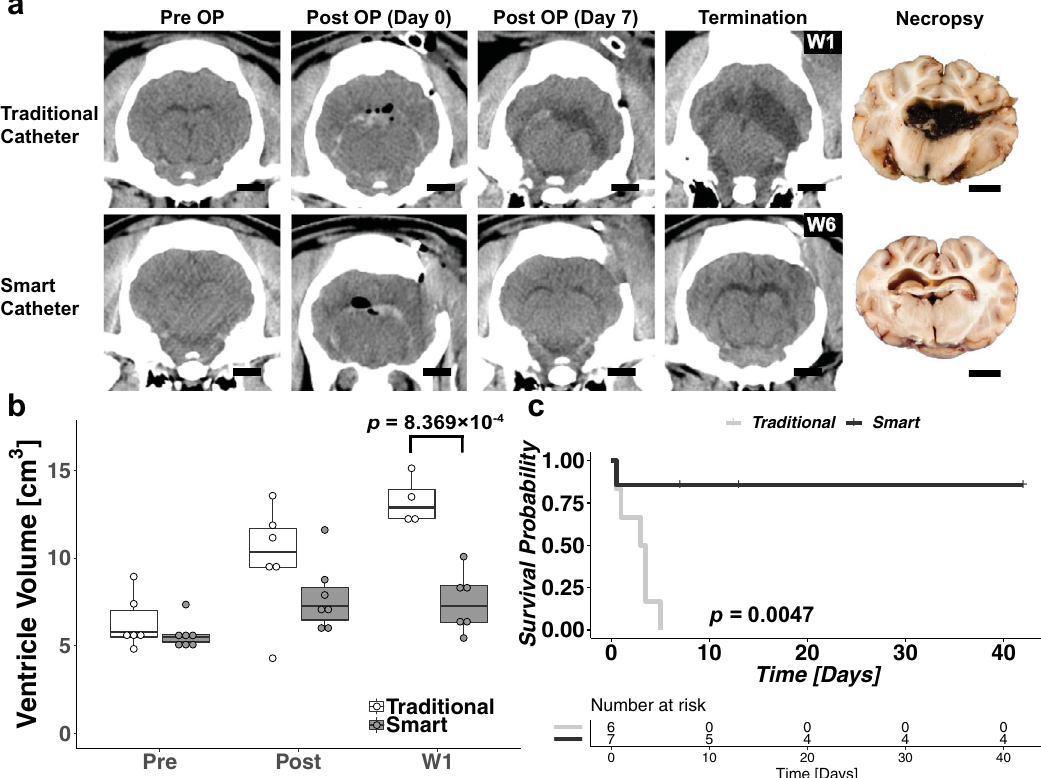
Fig. 5 In vivo evaluation results. a Comparison of CT scans over the course of implantation for animals with traditional catheters (Control) and smart self- clearing catheters (Treated). Note the difference in ventricular volume before and after the surgery. There are signs of air pockets following the surgery (Post Op). After a week, the air pockets are resorbed but there is signi fi cant evidence of ventriculomegaly and hematoma in Control animals. The CT scan of the Control animal shows a signi fi cantly larger ventricle fi lled with hematoma compared to the Treatment animal. The photograph at necropsy also shows the enlarged ventricles. Scale bars = 1 cm. b Box plot of ventricle volume until week 1. The box plot shows the interquartile range, the horizontal lines within the boxes are median. The extended ventricle volume plot is available in Supplementary Fig. 7. Two-way ANOVA with Tukey ’ s HSD test indicated a signi fi cant difference in ventricle volume when treated with smart self-clearing catheters. Control animals with traditional catheters had a signi fi cant increase in ventricle volume by W1. c Kaplan – Meier survival plot with corresponding risk table. By week 1, the traditional shunt systems in all Control animals had failed whereas 80% of the shunt systems with self-clearing catheters remained obstruction-free with biweekly actuation. Supplementary Figure 8 shows the survival plot when infections are counted as on day 7 for peri-operative infection. The other rubbed his head on cage bars post-operatively. The skin edges were dehisced and were surgically re-closed on day 5 and again on day 7. Twelve days post-operatively his appetite decreased and 13 d post- operatively he was severely depressed, displayed nystagmus, and was euthanized.